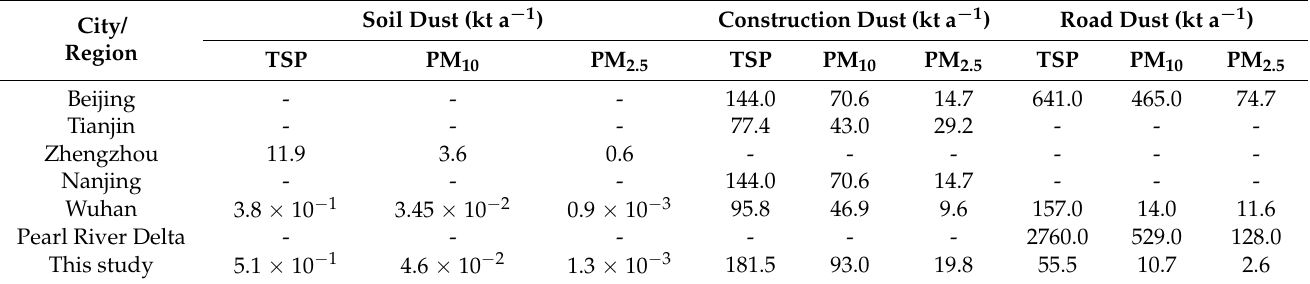
Table 5. The comparation between this study and the previous emission